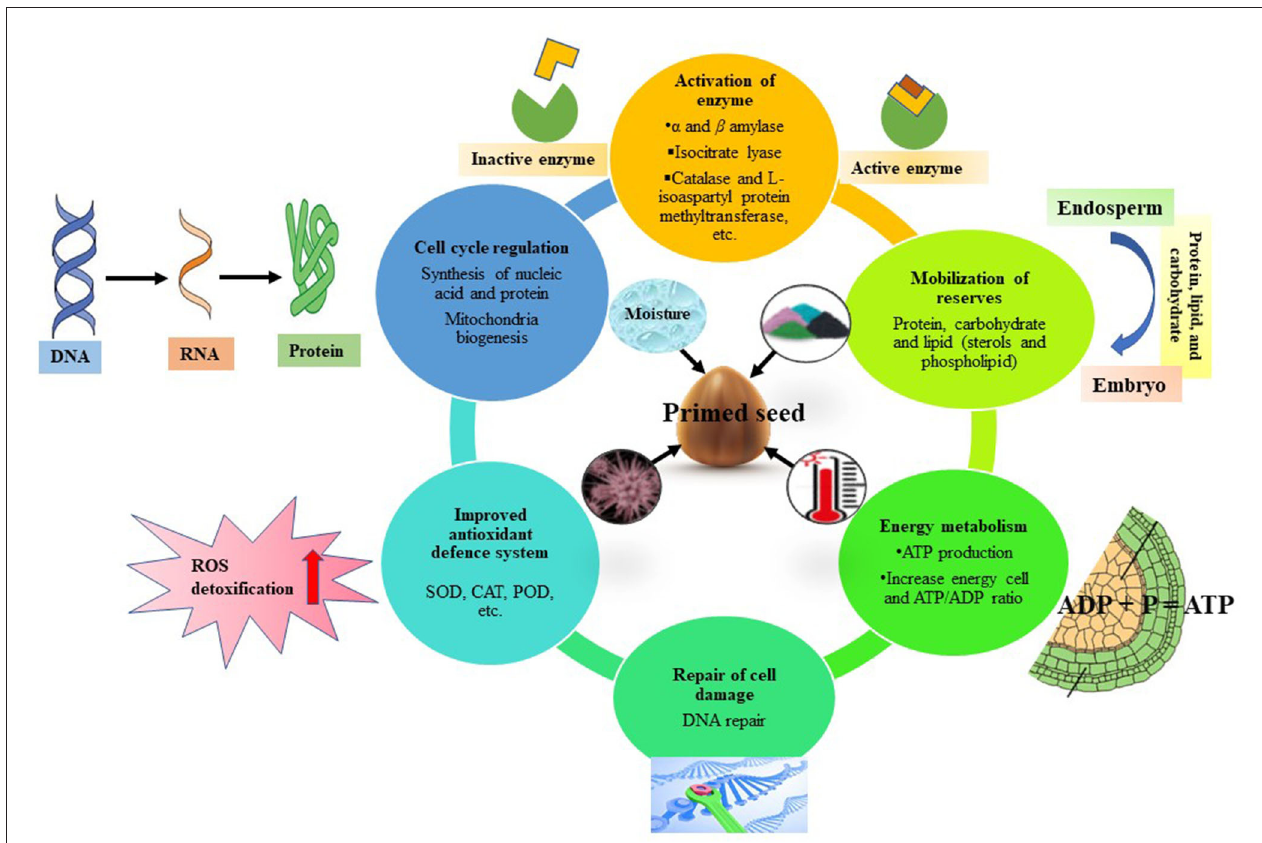
FIGURE 2 | Biochemical and molecular changes influenced by seed priming during stage II.